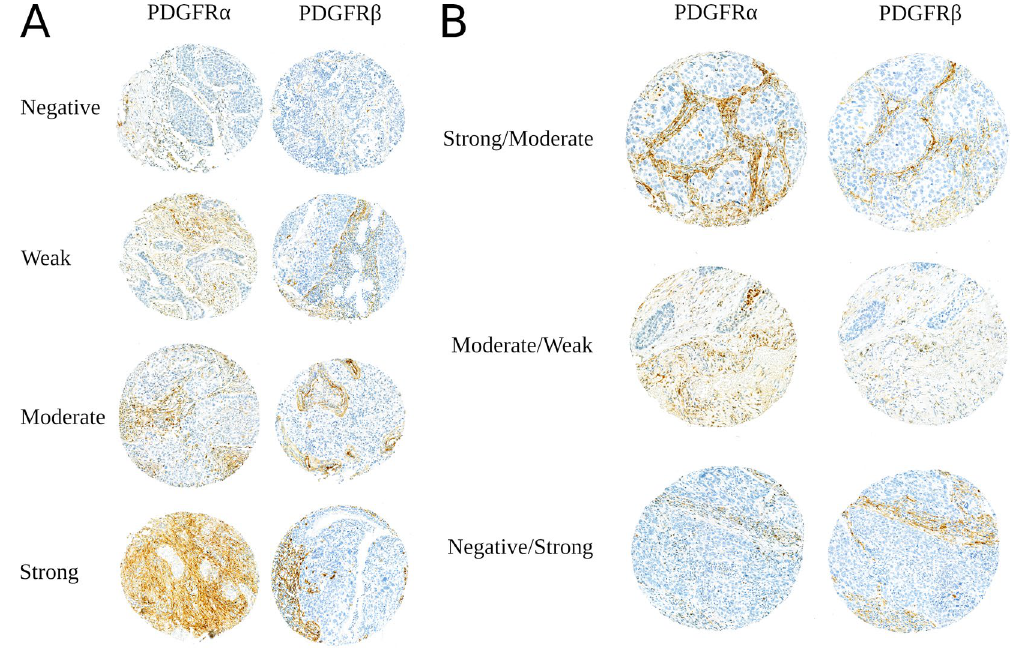
Figure 1. ( A ) Examples of TMA cores exhibiting negative, low, moderate and high expression of PDGFR α and PDGFR β . ( B ) Consecutive cores showing different scores for PDGFR α and PDGFR β . Areas with PDGFR expression clearly overlap in some cores while no overlap is observed for other cores. Abbreviations: PDGFR, platelet-derived growth factor